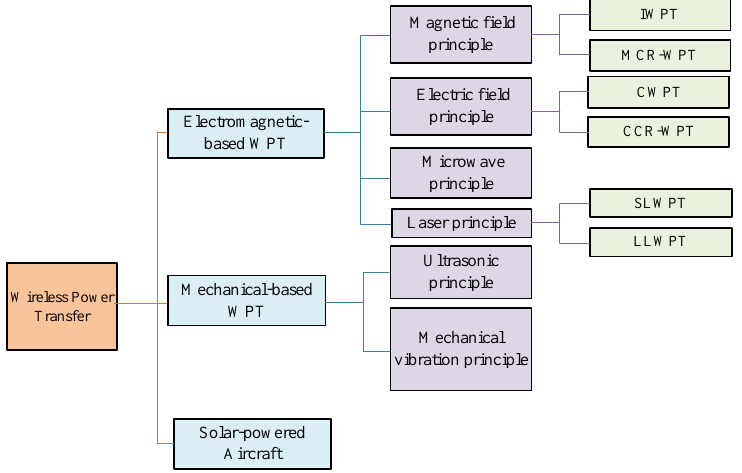
Figure 2. Classification of wireless power transfer technologies.